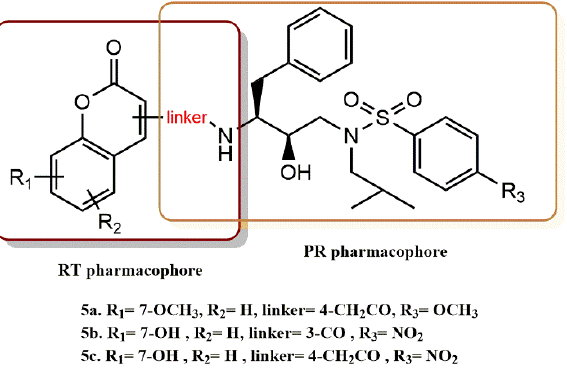
Figure 7. RT and PR pharmacophores of new active synthesized compounds 5 a -c .